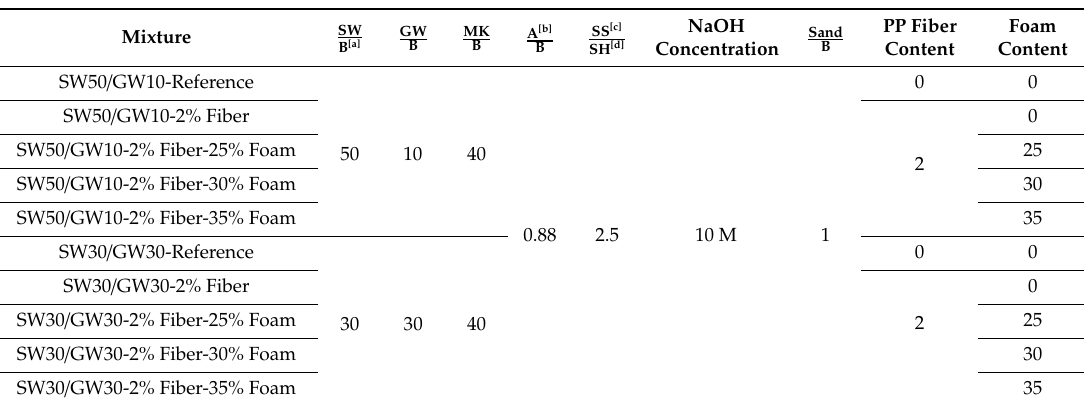
Table 3. Mix compositions design